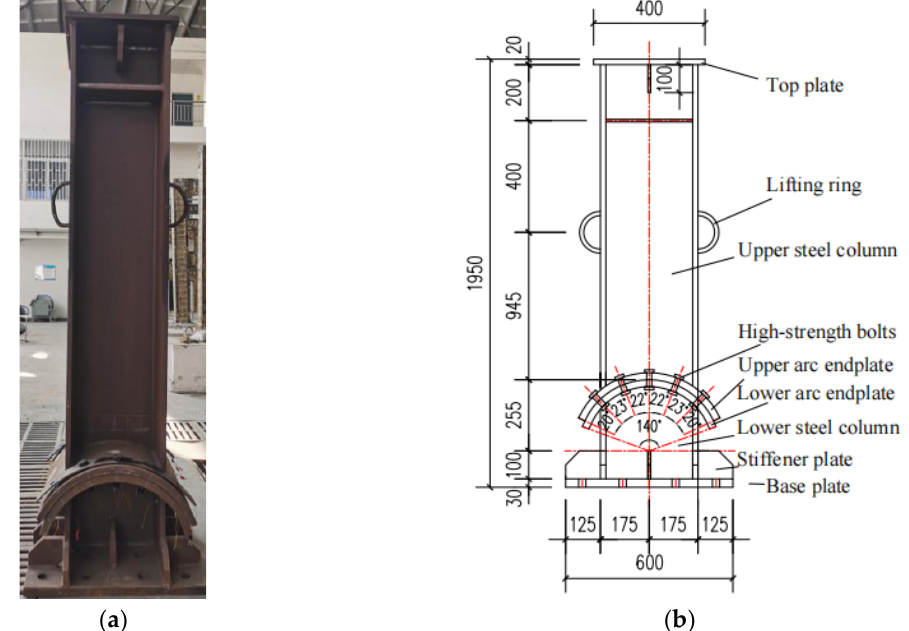
Buildings 2022 , 12 , x FOR PEER REVIEW Figure 3. Design details of the specimen (unit: mm) : ( a ) Specimen; ( b ) Dimensional drawings. Figure 3. Design details of the specimen (unit: mm) : ( a ) Specimen; ( b ) Dimensional drawings. Figure 3. Design details of the specimen (unit: mm): ( a ) Specimen; ( b ) Dimensional drawings.